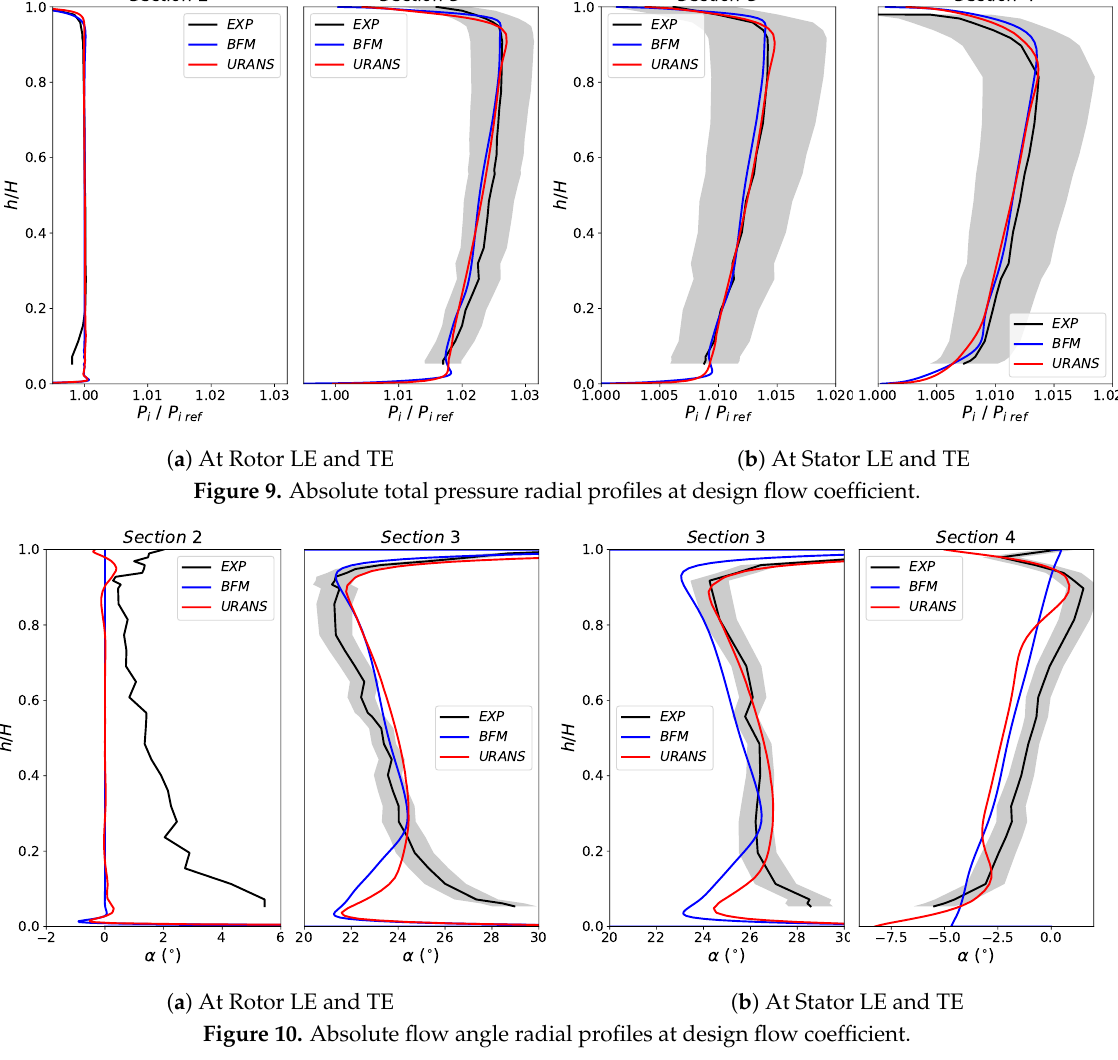
Figure 10. Absolute flow angle radial profiles at design flow coefficient.